Question: Condense the content of this figure into a single sentence.
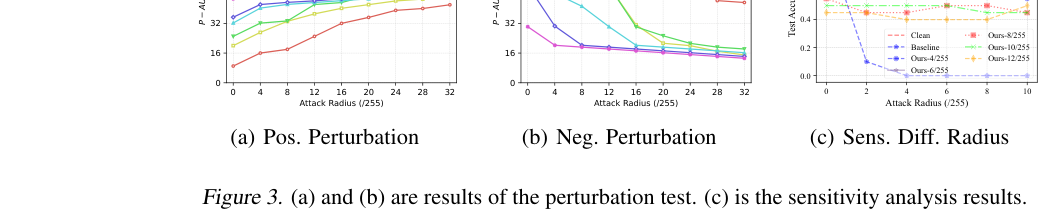
Answer: (a) show that the P-AUC of our method consistently achieves the lowest value when we perform attacks with a radius ranging from 0/255 to 32/255, which suggests that our method are more faithful and interpretable. Similarly, as for Neg. perturbation, the results in Figure 3(b) also suggest that our method is more robust than other baselines when removing unrelated pixels, and indicate that our method can identify important pixels under corruptions.